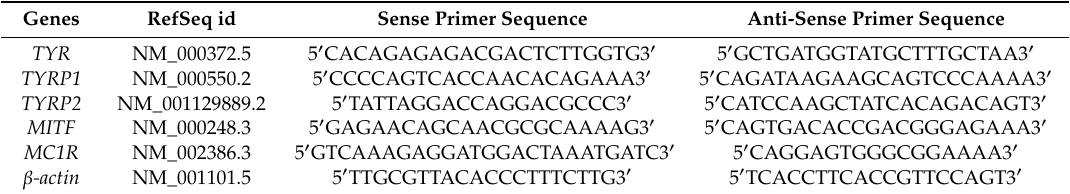
Table 6. The primer sequences of genes in